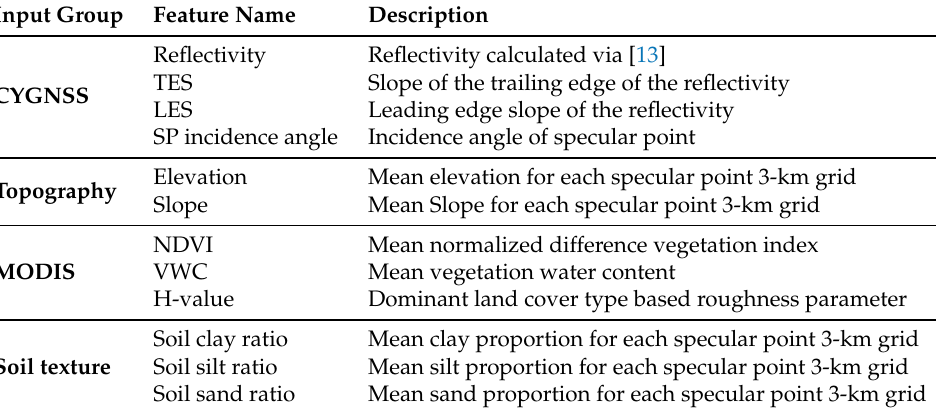
Table 2. Physical features considered for the machine learning (ML)-based SM retrieval